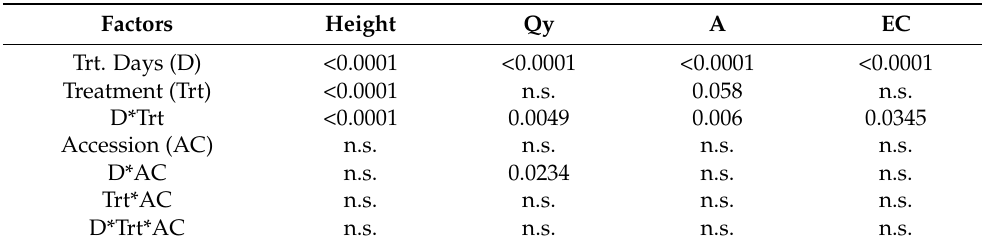
Table 4. ANOVA of effects of treatment days, heat stress, accessions, and their interactions on plant height, PSII efficiency, photosynthesis rates, and leaf heat damage levels. n.s. indicates no significant difference. * indicates the interaction between variables.